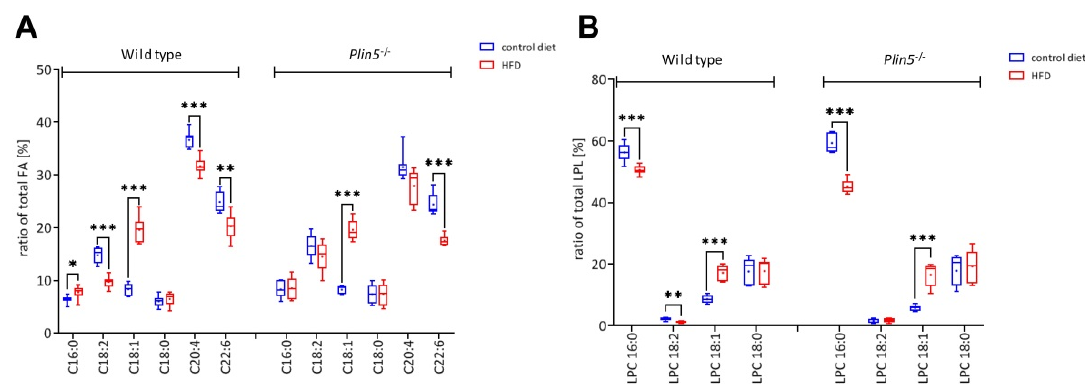
Figure 7. PLIN5 induces hepatic arachidonic acid. Lipid analysis by electrospray ionisation-ion trap mass spectrometry (ESI-IT MS) was performed in wild type (WT) and Plin5 − / − animals under normal chow (NC) and high-fat diet (HFD) 30-week administration ( n = 4–7 animals / group). The phospholipase A 2 enzymatic digest revealed ( A ) di ff erences in the hepatic fatty acids cleaved from sn -1 position of phospholipids and ( B ) lysophosphatidylcholines (LPCs) including the head group with the glycerol back bone and the fatty acids in sn -2 position. Statistical analyses were performed using GraphPad Prism 8. Data are given as mean ± SD. For the verification of significances, nonparametric and two-tailed t-tests were performed. Statistical significance was determined using the Holm-Sidak method, with α = 0.05. Significance was indicated by * p < 0.05; ** p < 0.01; *** p < 0.001.